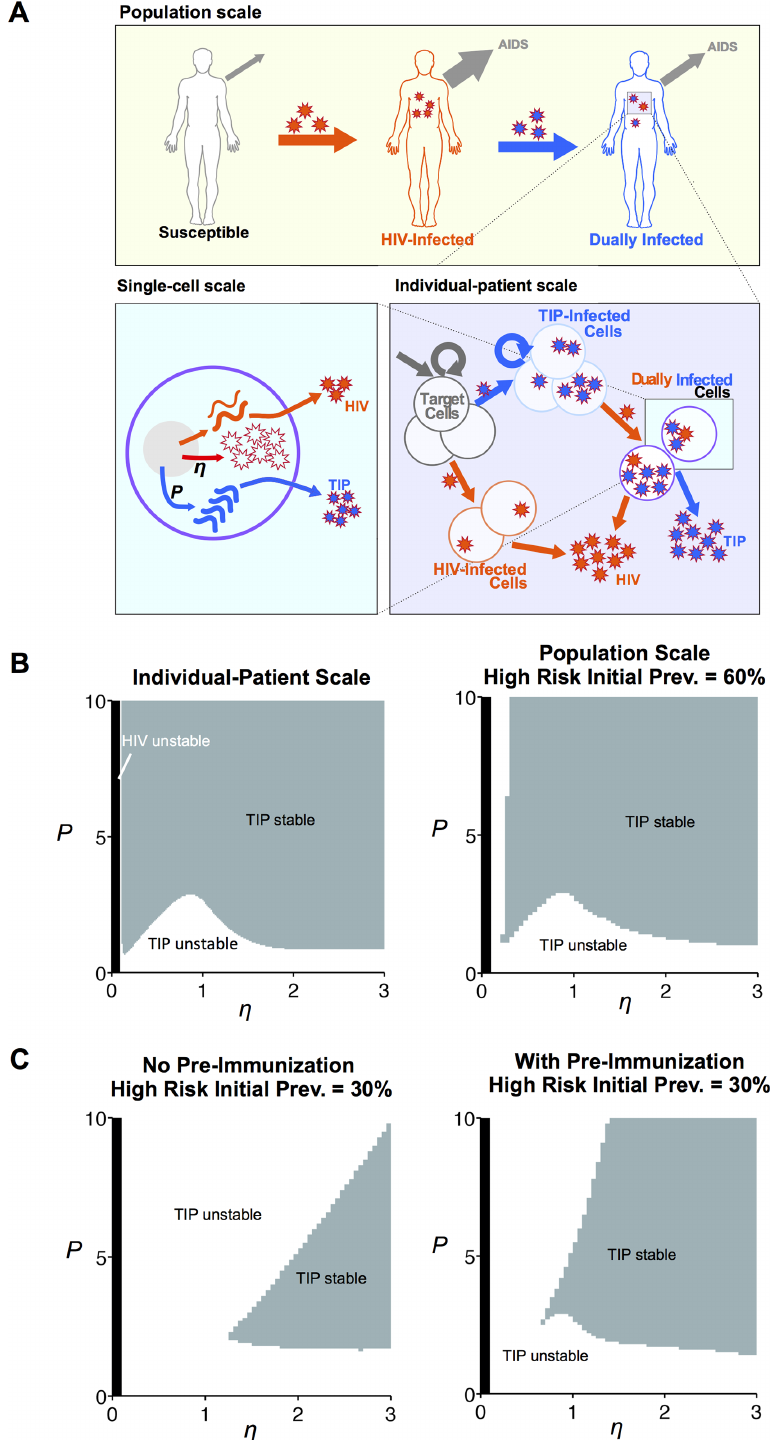
Fig 1. TIP and HIV are dynamically co-stable across multiple biological scales. (A) Schematic of the multi-scale mathematical model that tracks HIV and TIP levels across three biological scales: the single-cell scale, the individual-patient scale, and the population (i.e., epidemiological) scale. The cell-scale model quantifies TIP and HIV production in individual cells, as TIP and HIV genomic RNAs (gRNAs) compete for viral capsid proteins (i.e., public goods) produced by HIV (Section A in S1 Text). The design parameter